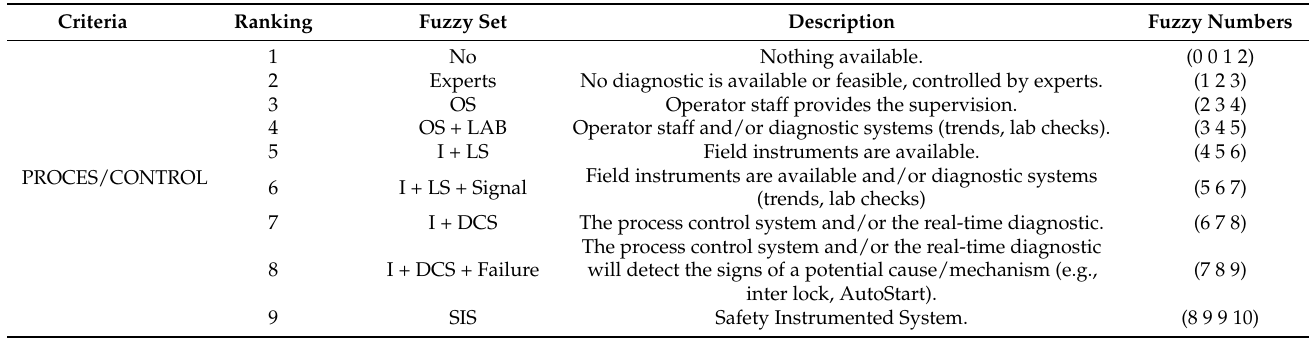
Table 3. Selection criteria for failure modes detectability